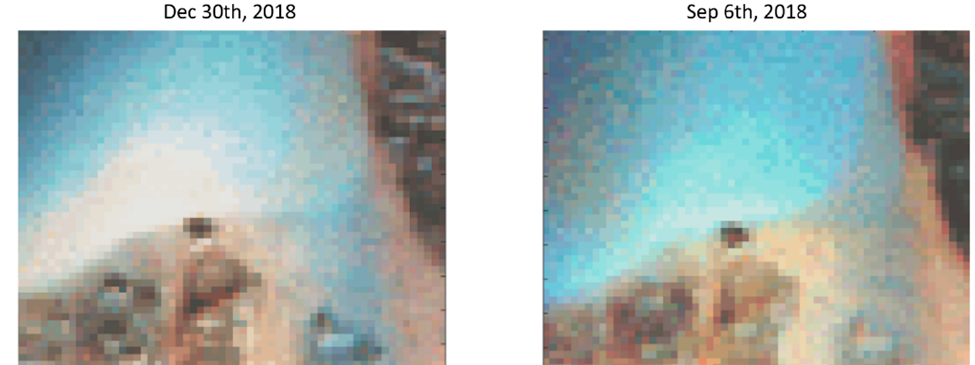
Figure 17. Sentinel-2 optical images of dune D3 acquired at different times. Changes in dune luminance between the two scenes are evident.